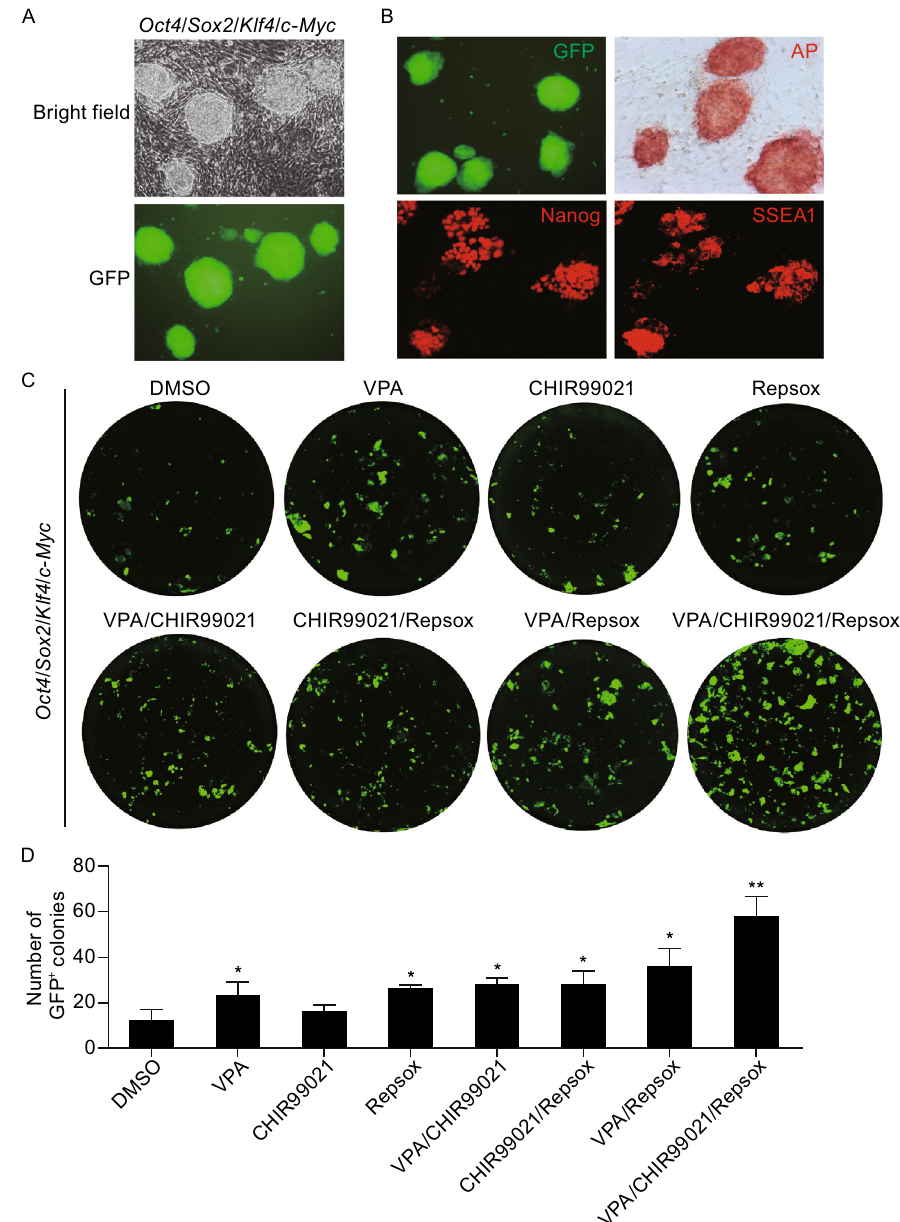
Figure 1. Chemical compounds promote cell reprogramming in vitro . (A) Representative images of typical GFP + colonies generated from OG2-MEFs at day 10 post-infection of retroviruses expressing Oct4 , Sox2 , Klf4 , and c-Myc . (B) Characterization of Yamanaka factors-induced pluripotent stem cell colonies from OG2-MEFs with alkaline phosphatase (AP) staining and immuno fl uorescent staining of pluripotent markers Nanog (red) and SSEA1 (red). (C) Generation of pluripotent stem cell from Yamanaka factors-induced OG2-MEFs under treatment of diverse chemical compounds. Images of GFP + colonies were taken on day 10 post-infection. VPA, 0.5 mmol/L. CHIR99021, 3 μ mol/L. Repsox, 1 μ mol/L. (D) Quanti fi cation of GFP + colonies in (C). All fi gures are representative of three independent experiments ( n = 3). All data are presented as mean ± SD. * P < 0.05, ** P < 0.01 vs.